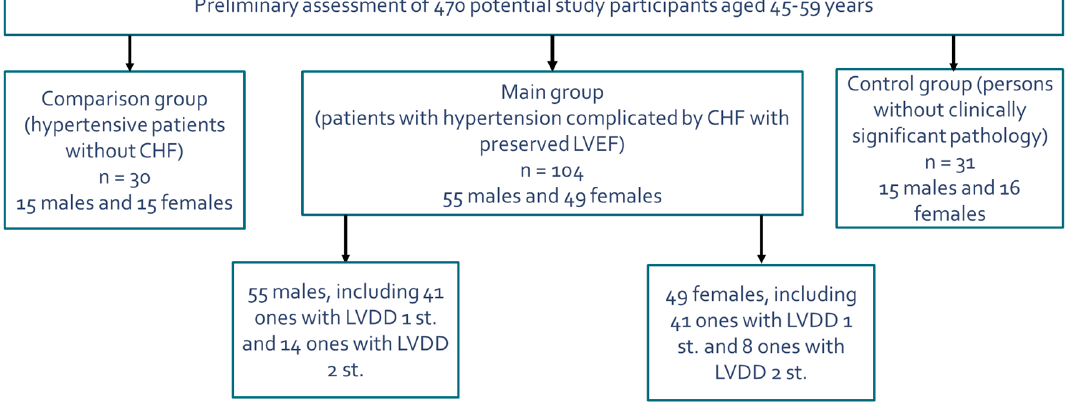
Figure 1. Scheme of the selection of study participants in the main group (combination of essential arterial hypertension and heart failure with preserved left ventricular ejection